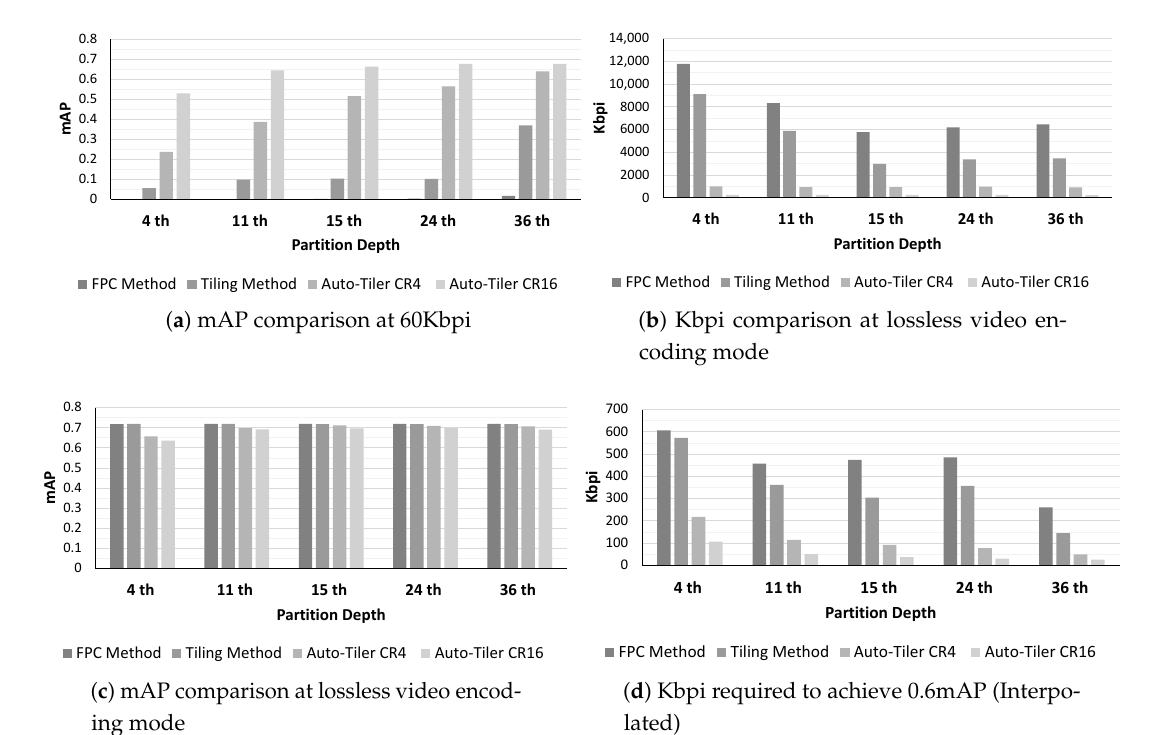
Figure 12. mAP comparison at 60 Kbpi and lossless video encoding mode, Kbpi comparison at lossless video encoding mode, and Kbpi required to achieve 0.6